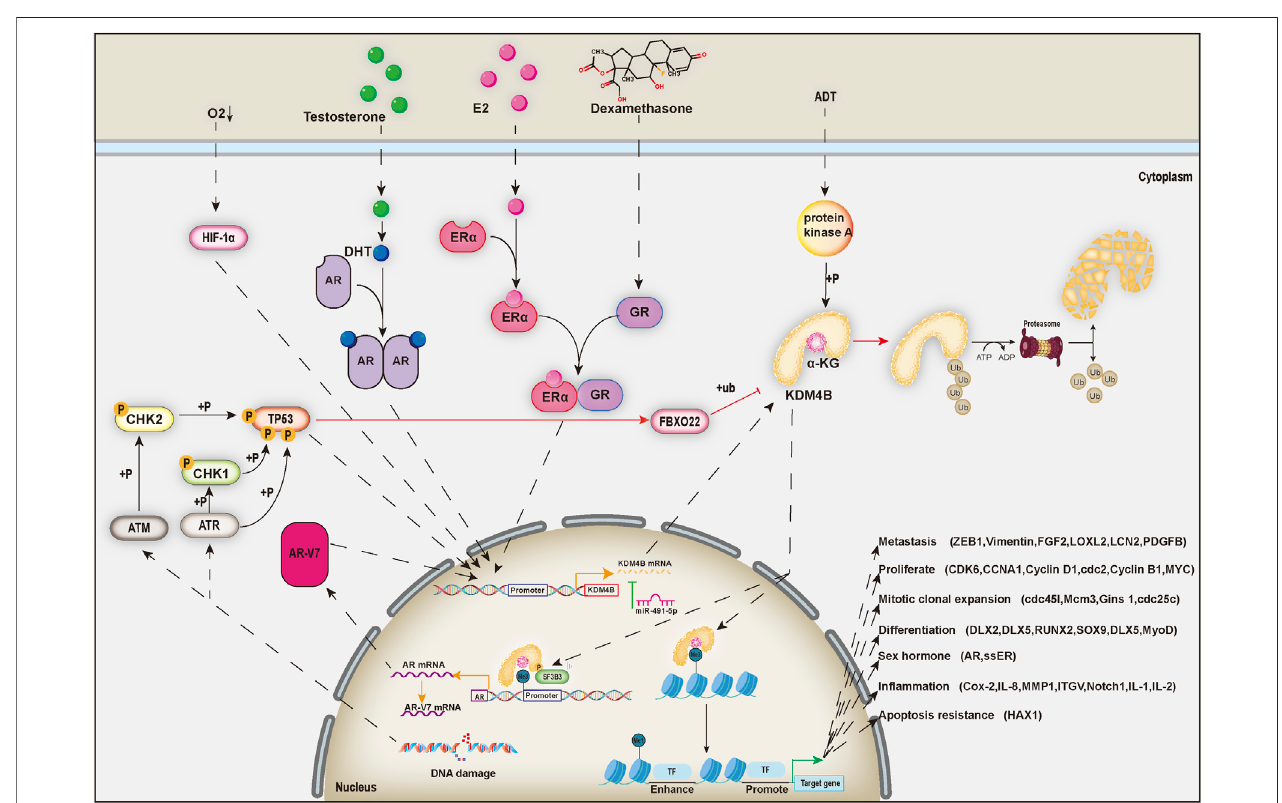
FIGURE 2 | KDM4B plays an intermediate role in cell signal